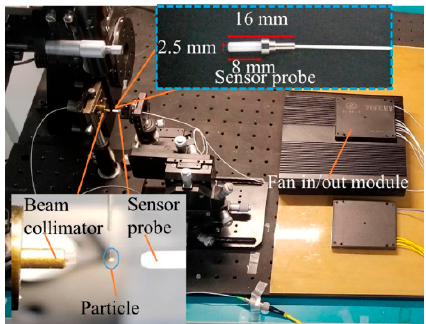
Figure 5. Photo of the major part of the experimental setup. An enlargement of the sensor probe is shown in the picture.